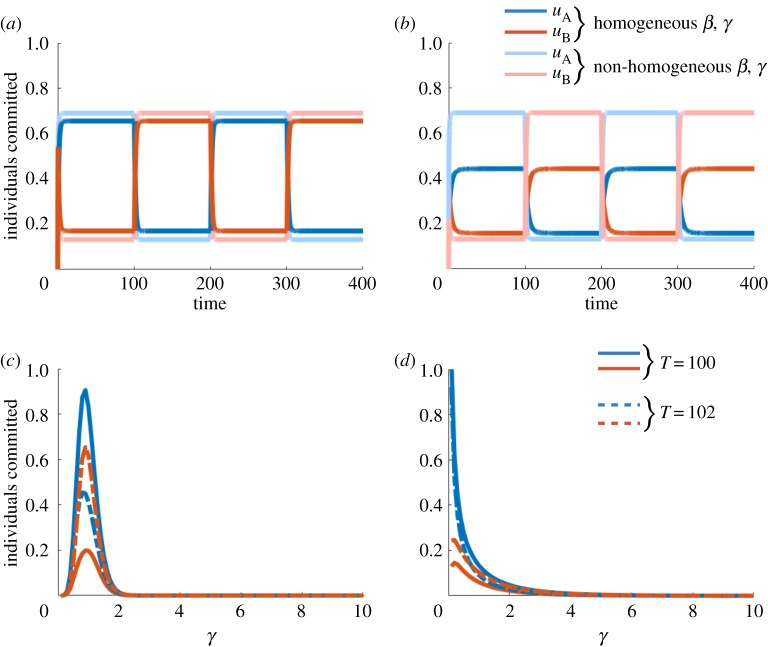
Heterogeneity in the recruitment and forgetting rates can decrease consensus and adaptivity. Consensus slightly decreases when simulating equation (B 1) with (a) weak heterogeneity β ∈ Γ (20, 0.1) and γ ∈ Γ (10, 0.1) (heavy lines) as opposed to (light lines) constant recruitment (β = 2) and forgetting (γ = 1) as in equation (2.1), and (b) consensus decreases more when more dramatic heterogeneity is considered: β ∈ Γ (1, 2) and γ ∈ Γ (0.5, 2). Adaptivity decreases with heterogeneity as well, as we see for (c) weak heterogeneity distribution, individuals still abandon relatively quickly after a change point, but (d) more slowly when rates are drawn from distribution with strong heterogeneity. Distributions are independent, so p(β, γ) = p(β)p(γ); switching period T = 100 min; other parameters α = 2, ρ = 1, and τ = 0.